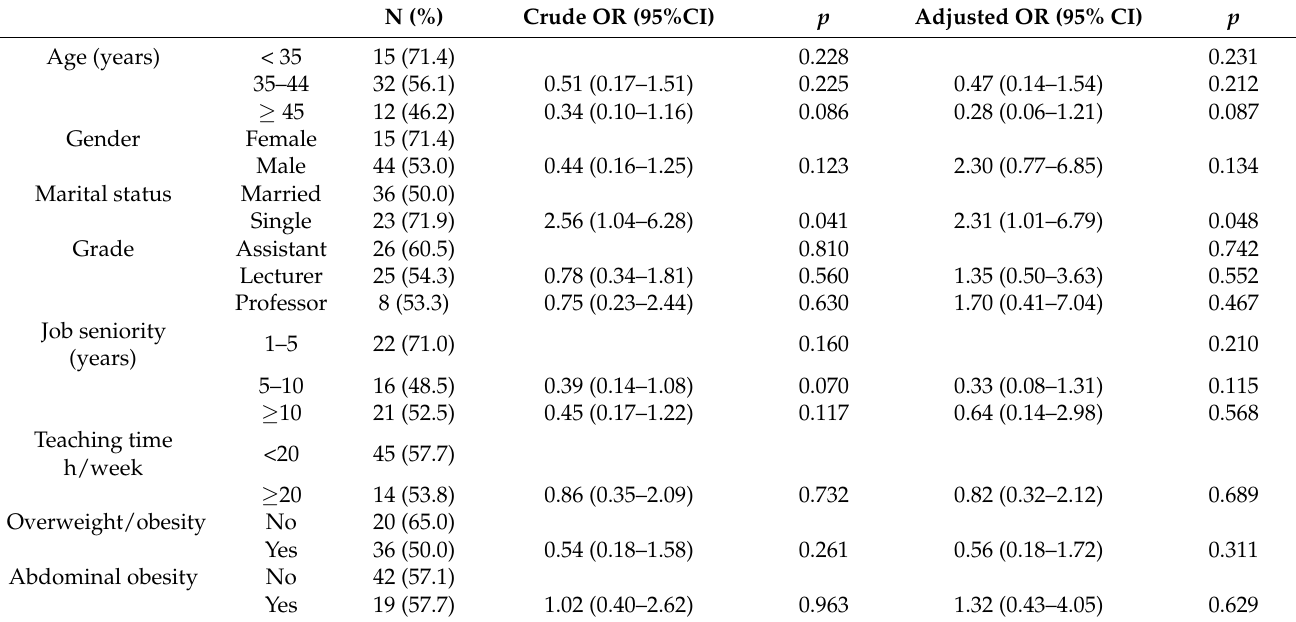
Table 4. Association of MSDs during previous 7 days with socio-demographic, socio-professional and anthropometric variables.